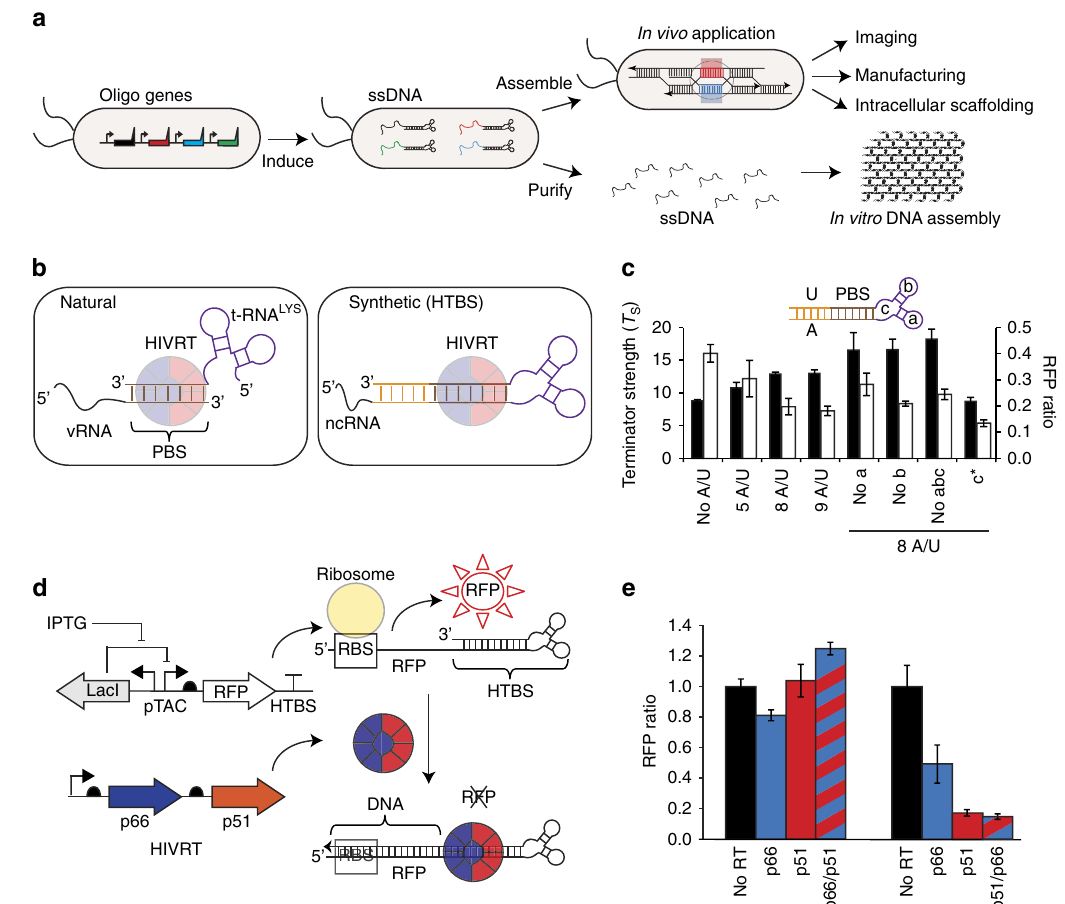
Figure 1 | Genetic part design for in vivo ssDNA production. ( a ) The processes of ssDNA production and in vitro / in vivo assembly are shown. ( b ) The mechanism for the priming of HIVRT is compared for the natural system and the HTBS genetic part. HTBS, HIV terminator-binding site; HIVRT, HIV reverse transcriptase; ncRNA, non-coding RNA; PBS, protein-binding site; vRNA, viral RNA. ( c ) The terminator strength (black) and the RFP ratio (white) were measured for variations of HTBS parts. The terminator strengths were calculated as described previously 48 by comparing the expression of two fluorescent reporters, one placed before and one after the HTBS part (for their plasmid map, see Supplementary Fig. 14). The knockdown in RFP expression corresponds to the experiments shown in d . To account for different baseline expression levels associated with terminator modifications, the RFP fluorescence generated by each of the different HTBSs is divided by the fluorescence measured in the absence of HIVRT (RFP ratio). Data shown represent the averages of three independent experiments performed on different days. For the different HTBS sequences, see Supplementary Table 1. ( d ) A schematic showing the use of HIVRT to knockdown gene expression is shown. ( e ) The impact of different combinations of the HIVRT subunits (columns coloured: black-no RT; p66-blue; p51-red and p66/p51-blue/red) on the RFP knockdown. The left sets of bars are a control containing a strong terminator (BBa_B0054) and the right sets of bars are for the HTBS. Data shown represent the averages of three independent experiments performed on different protocol to isolate DNA products from lysed cells, which can be visualized using non-denaturing gel electrophoresis (Methods).